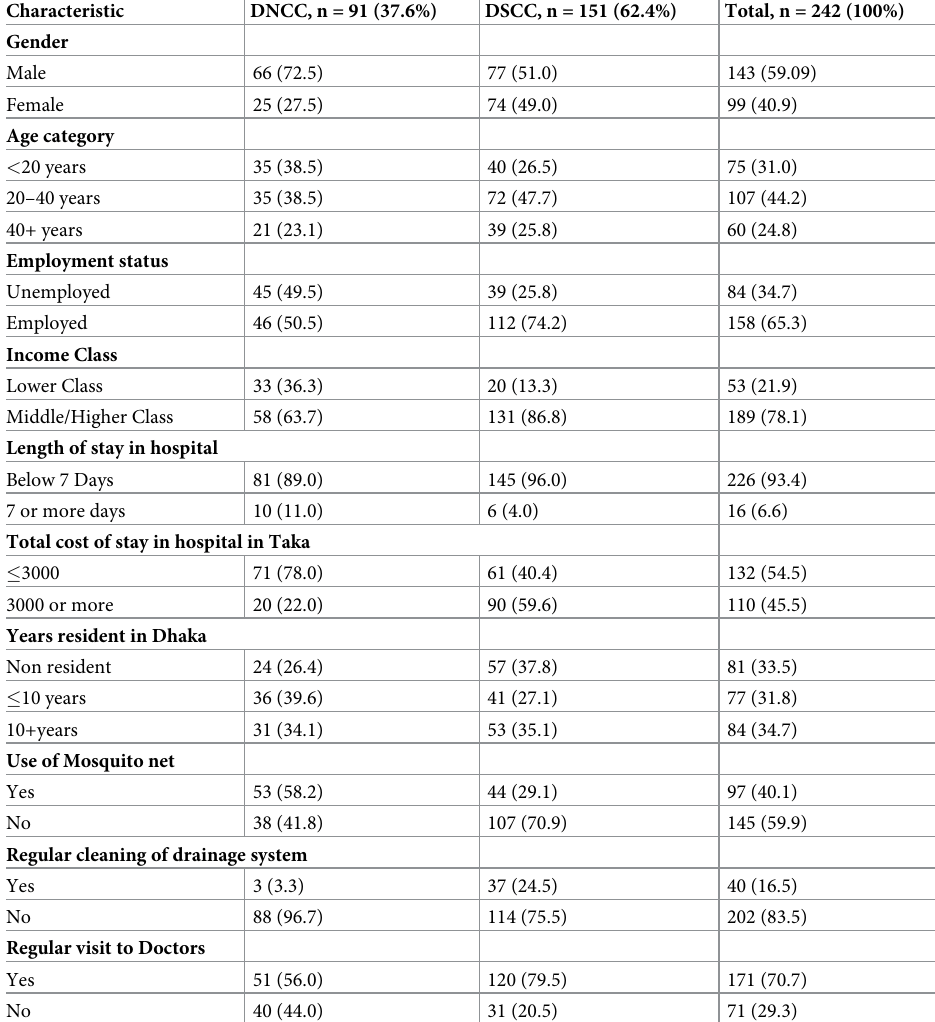
Table 1. Descriptive statistics of the sociodemographic characteristics of respondents from Bangladesh.